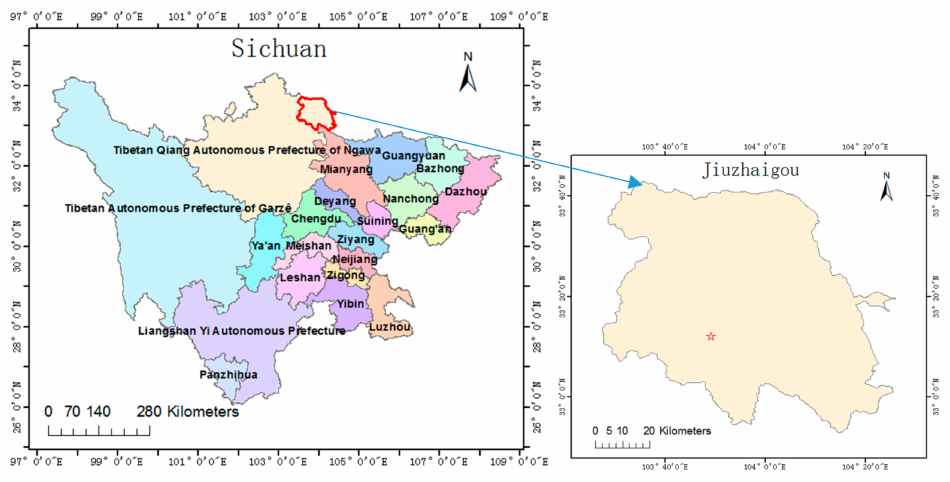
Figure 5. Location of the study area.